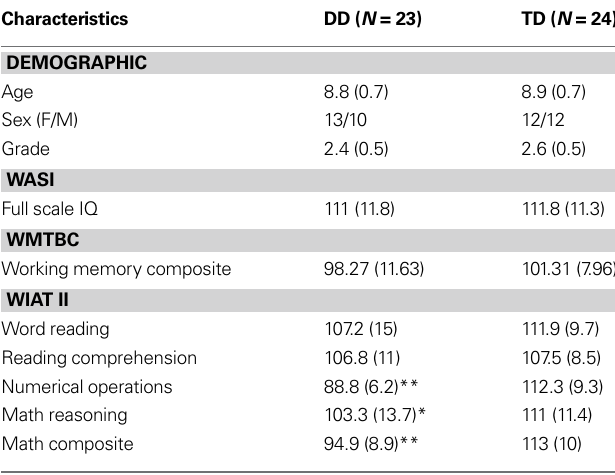
Table 2 | Demographic and neuropsychological characteristics of participants.